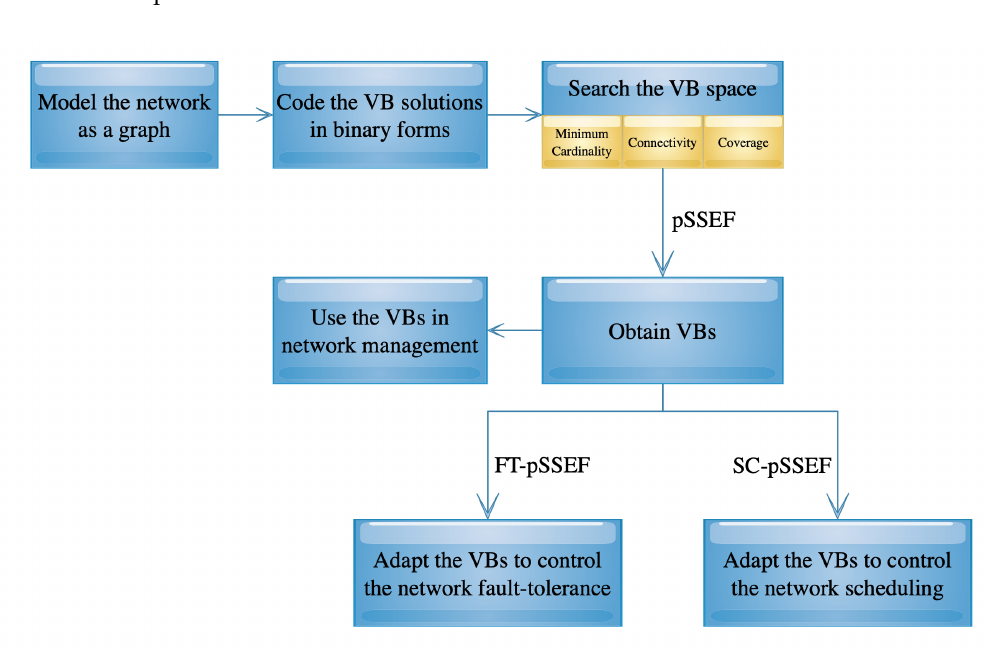
Figure 1. Methodology